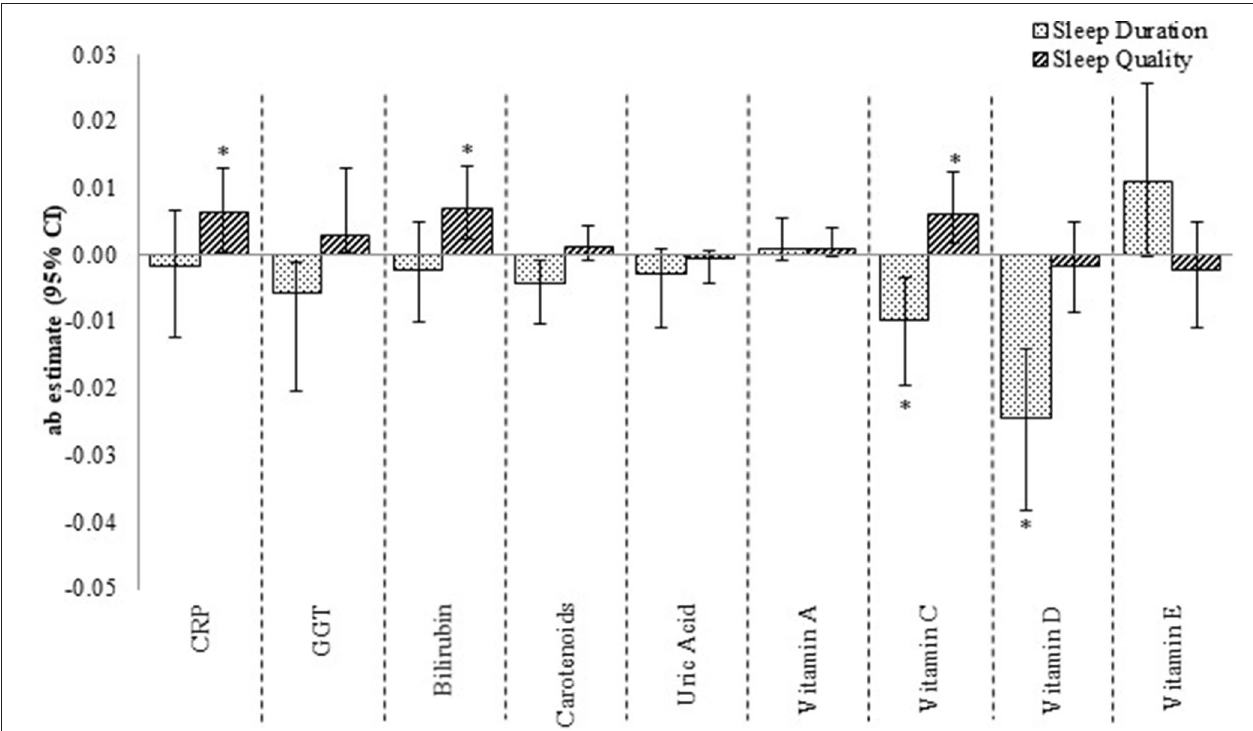
FIGURE 3 | The contribution of CRP, GGT and micronutrient antioxidants to the sleep–glycosylated hemoglobin relationship. ab estimate, amount of mediation or contribution by the mediatory variable (moderate effect when ab ≥ 0.09, and large effect when ab ≥ 0.25) CI, confidence interval. *p < 0.05, 95% CI are bias-corrected, bootstrapped values. Each mediator was tested one-by-one in the mediation model.